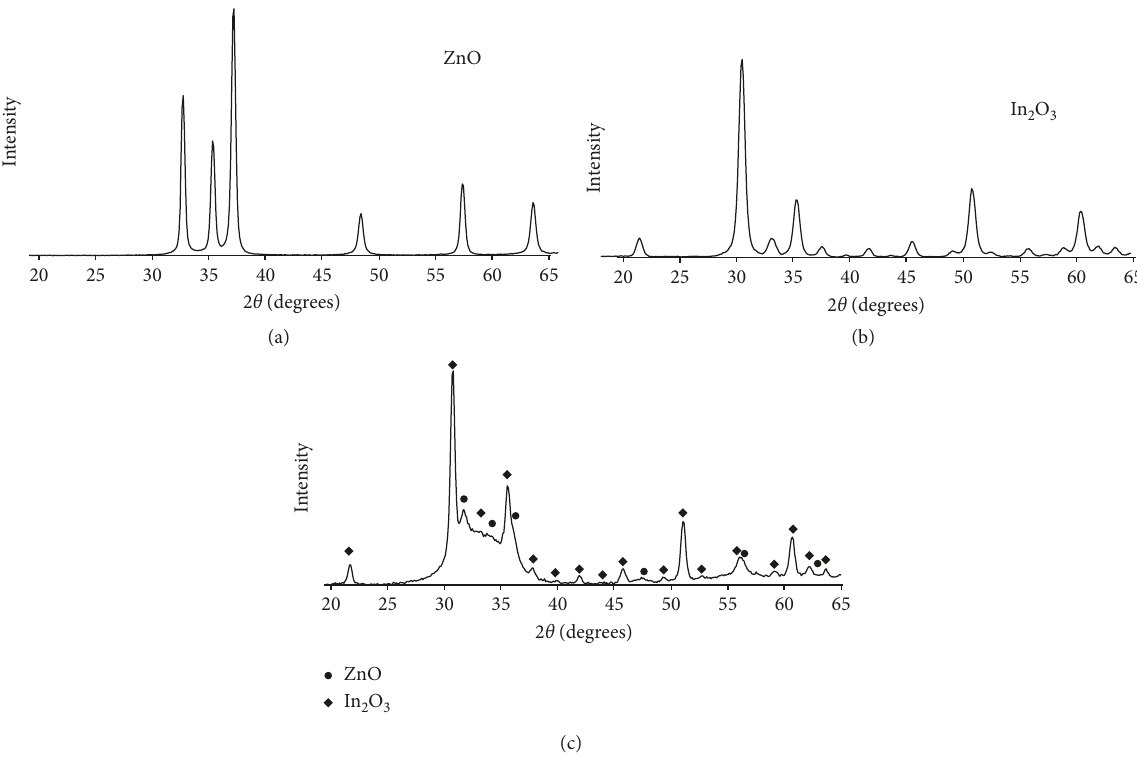
Figure 4: XRD patterns of nanofibers after annealing for samples IZO9 (a), IZO1 (b), and IZO5 (c).